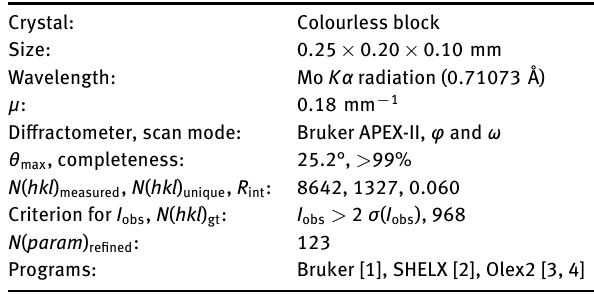
Table 2: Fractional atomic coordinates and isotropic or equivalent isotropic displacement parameters (Å 2